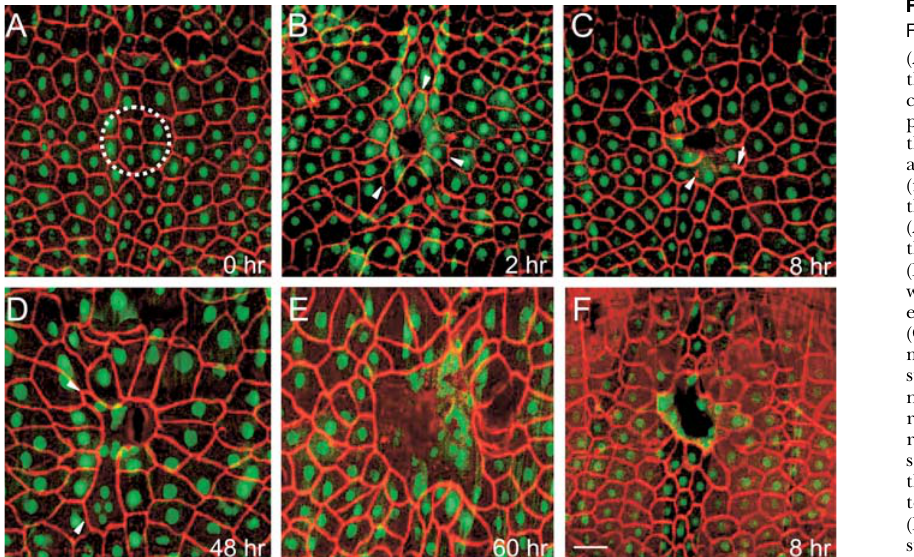
fusions of peripheral cells with the central syncytium. Other peripheral cells have oriented toward the syncytium but not fused with it. (E) 60 h postwounding. A large syncytium with more than 30 nuclei. (F) 8 h postwounding. Larva was treated as above but immunostained for Coracle (red), a septate junction component. The central syncytium contains nine nuclei. Bar, 50 l m. DOI: